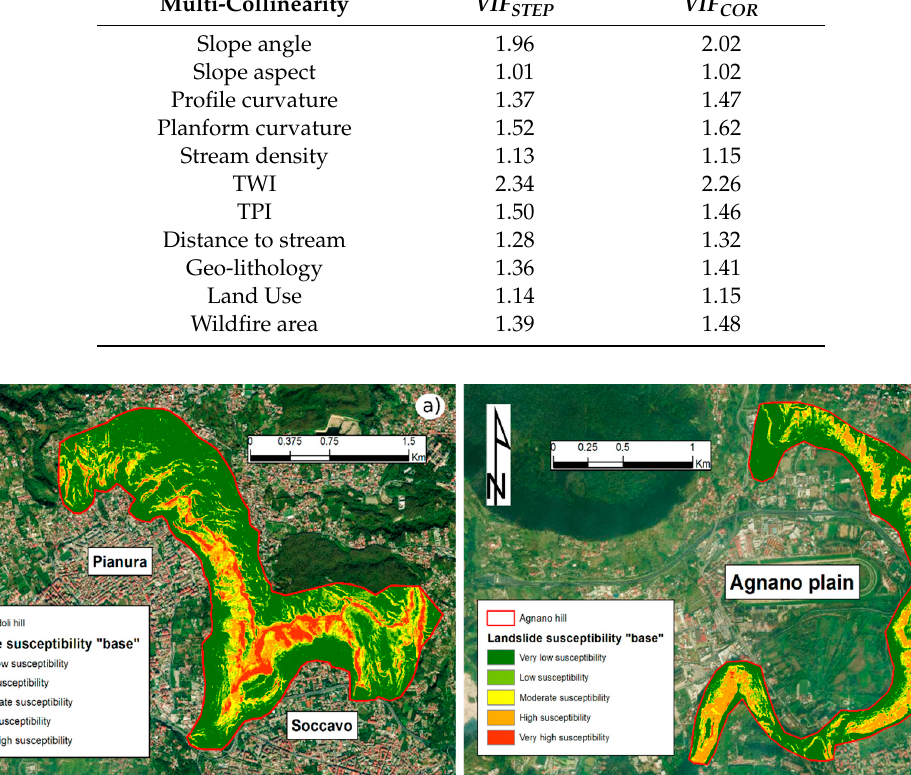
Figure 5. “Base” ensemble susceptibility maps. ( a ) Weighted mean ensemble susceptibility map of the Camaldoli hill; ( b ) weighted mean ensemble susceptibility map of the Agnano hills.